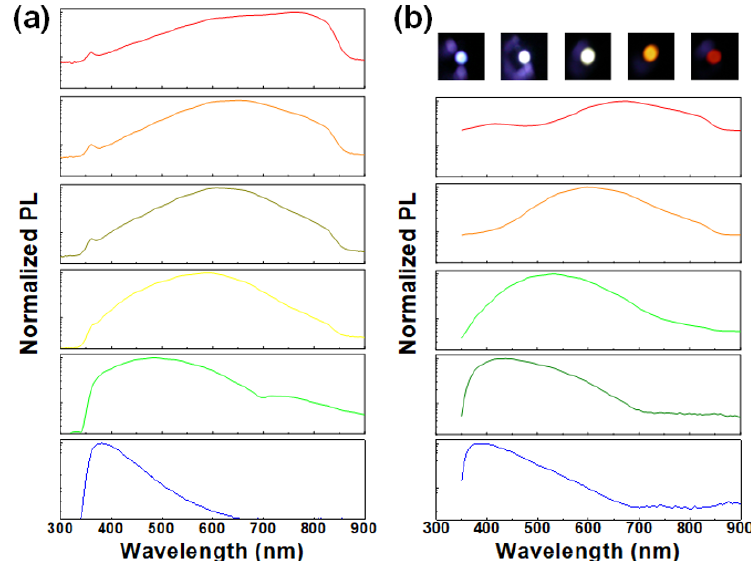
Figure 3. Normalized PL spectra of the buried Si-QDs in ( a ) SiO x and ( b ) SiN x host matrix.